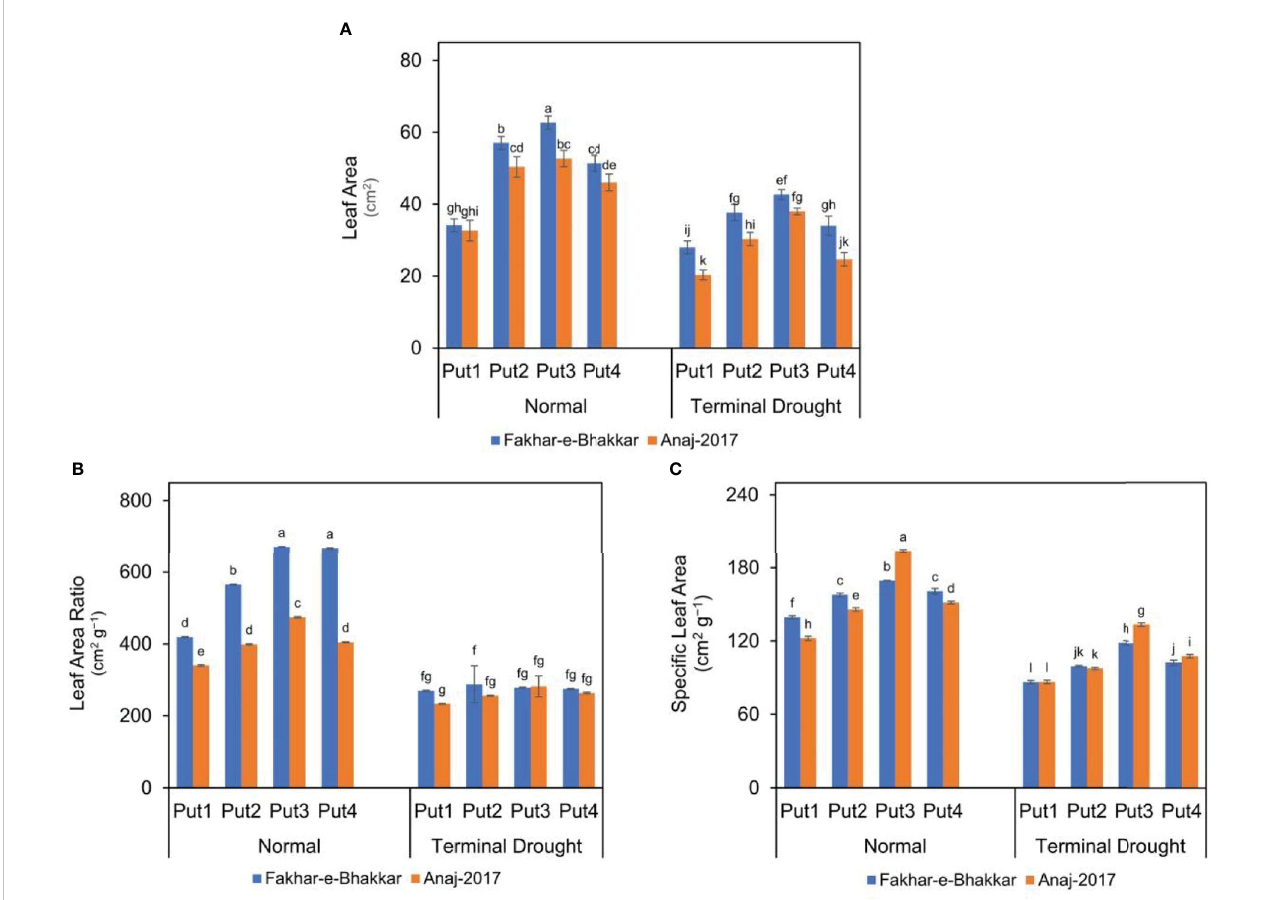
FIGURE 1 Effect of putrescine on the leaf area (A) , leaf area ratio (B) , and speci fi c leaf area (C) of two wheat cultivars under normal and terminal drought conditions. Abbreviation: PPM, parts per million, Put1, putrescine 0 PPM (untreated control); Put2, putrescine 0.5 PPM; Put3, putrescine 1.0 PPM; Put4, putrescine 1.5 PPM. The different letters above the bar columns indicate signi fi cant differences in mean ± SE at p< 0.05. At least three independent biological replications were considered for each